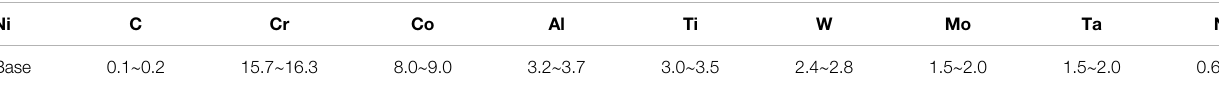
TABLE 1 | Chemical composition (in wt. %)of K438 Ni-based